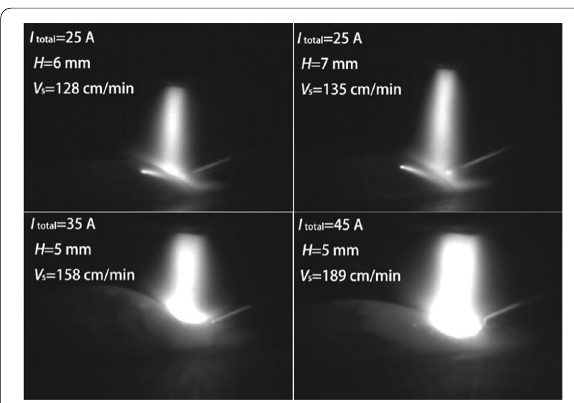
Figure 3 Metal-transfer modes corresponding to maximum wire feed rate